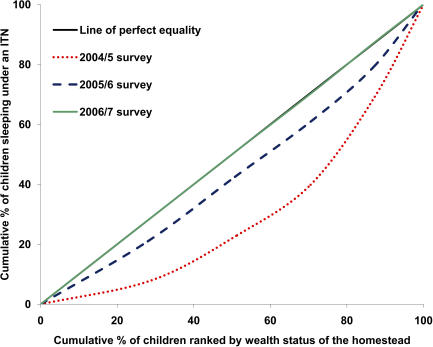
Degree of Inequality in Children Sleeping under an ITN in 2004/5, 2005/6, and 2006/7 in Homesteads of Different Wealth Status in the Four Districts in KenyaThe concentration curve below the line of perfect equality indicates that ITN use is concentrated among higher socioeconomic groups. When the curve is coincident on the line of perfect equality, then there is no wealth-related inequality in ITN use.